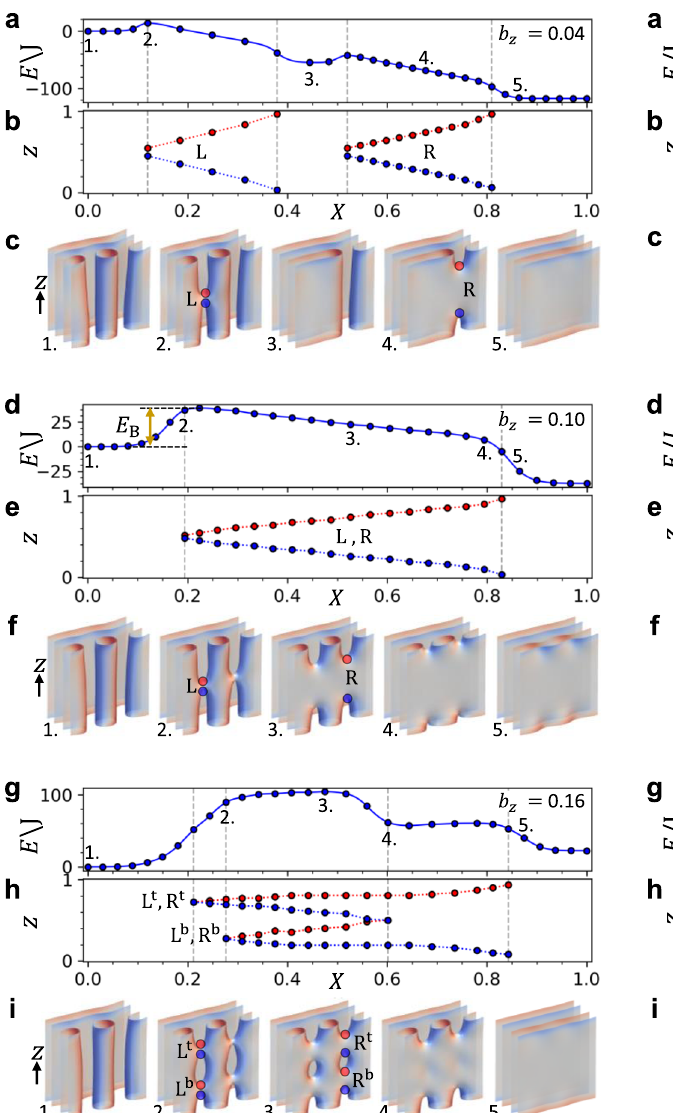
Fig. 4 Skyrmion to conical annihilation energy barrier simulations. a – i The results of the simulations for the skyrmion lattice to helical decay mechanism are shown at a range of applied magnetic fi elds. a , d , g The energy dependence of the magnetic state is plotted as a function of the reaction coordinate X along the minimum energy path (MEP). All data points have been subtracted by the energy of the initial state. b , e , h The z - axis trajectory of the left (L) and right (R) pairs of Bloch points plotted as a function of X as the skyrmion tube is annihilated. Vertical dashed lines highlight images where Bloch points are created or destroyed. Red and blue data points distinguish each Bloch point in a pair. c , f , i Selected three- dimensional visualisations of the simulation at speci fi c points along the MEP at each fi eld, as indicated by the corresponding numeric labels in a , d , g . The surfaces display s z = 0 contours, and have been coloured according to the local value of s x .